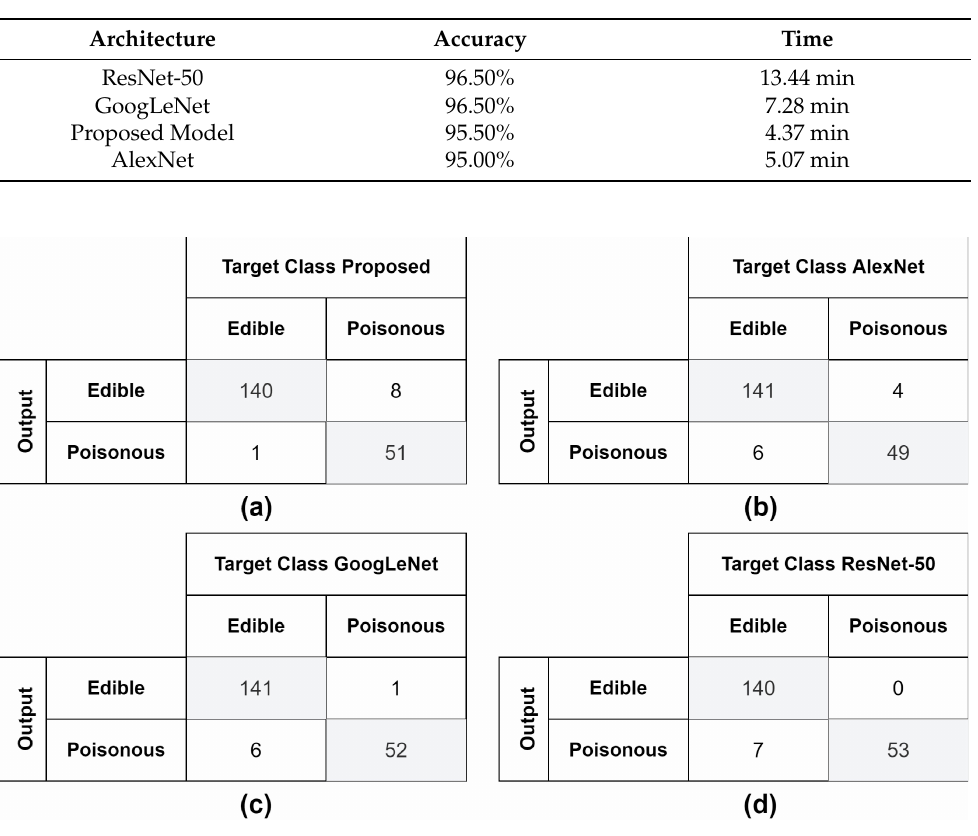
Figure 16. The confusion matrix for the R-CNN analysis: ( a ) proposed model; ( b ) AlexNet; ( c ) GoogLeNet; ( d ) ResNet-50.